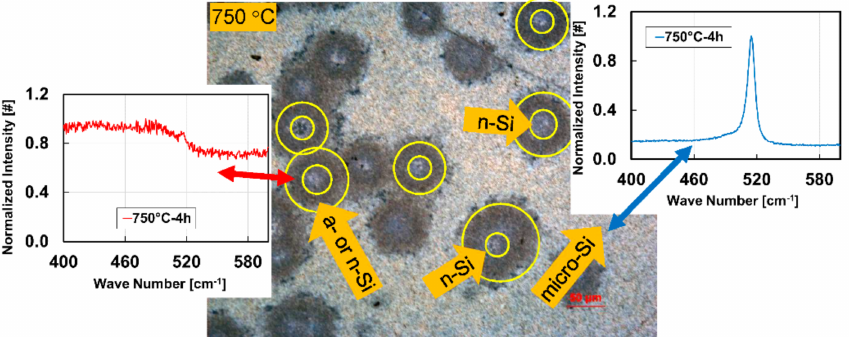
Figure 7. Optical micrograph of the CuIC micro-Si thin film with (glass / p-type Si / Cu) structure after annealing at 750 ◦ C (the scale bar is 50 µ